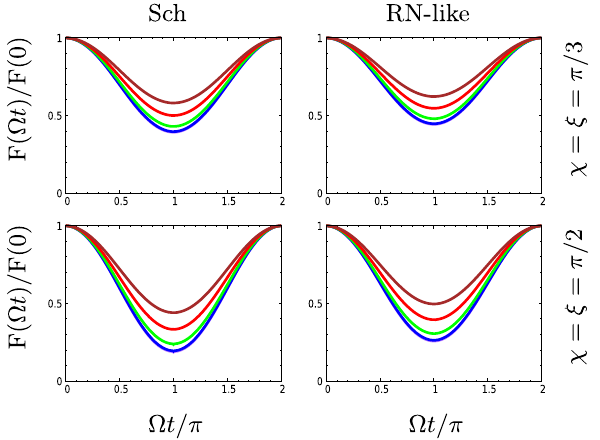
Fig. 18 Pulse profiles generated by ring-shaped cap emission. R = 4 M , q ∗ = − ( 0 . 75 M ) 2 , (cid:11) = 0 . 15, h = 3. The outer edge of the ring has anangularhalf-aperture θ e = 70 o ,whilethepurple,blue,green,redand browncurvescorrespondto θ i = 0 o ,10 o ,30 o ,50 o and65 o respectively.